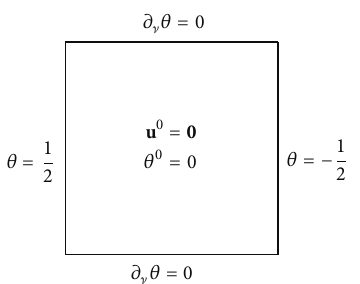
Figure 5: Example 21: initial and boundary values for thermal driven cavity